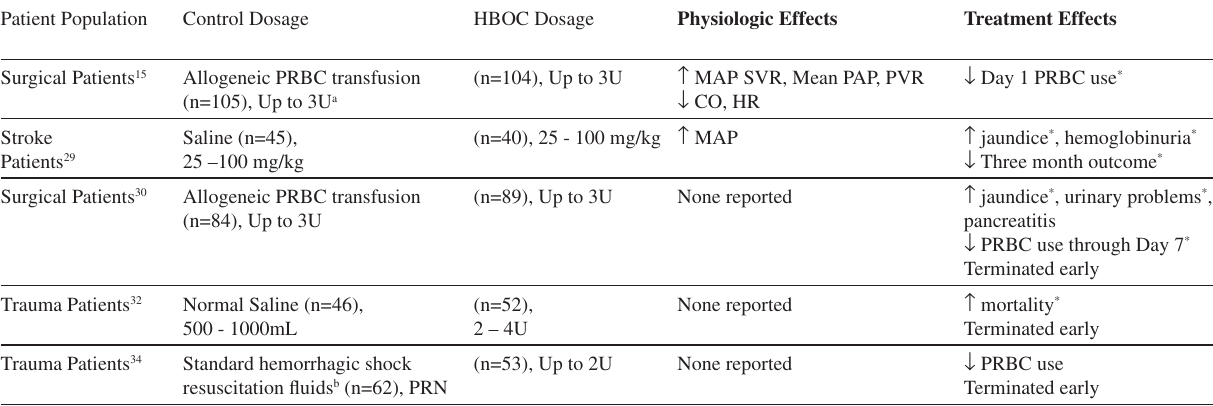
Table 2 - HemAssist clinical trials Patient Population Surgical Patients 15